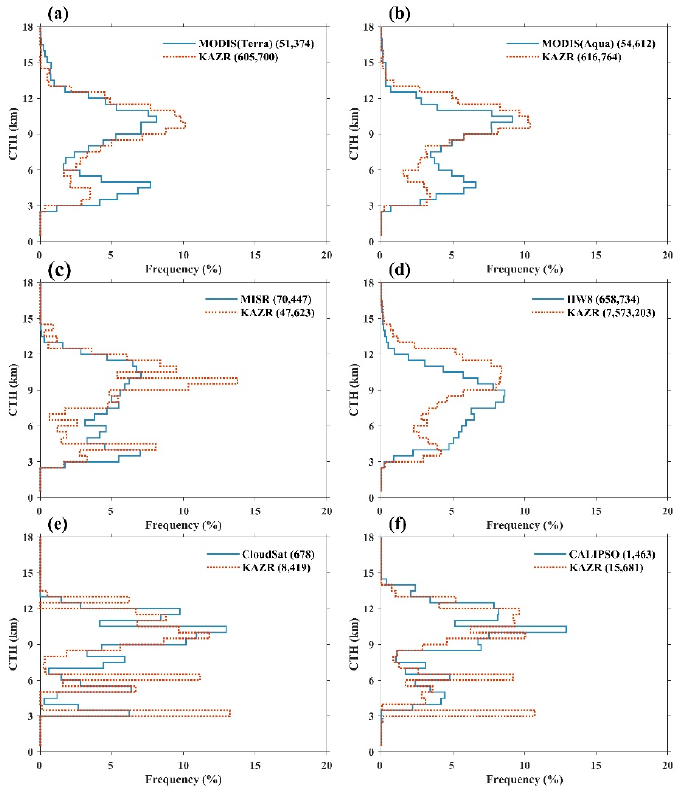
Figure 3. Frequency histogram of CTH (per 500 m interval) above the mean sea level for non- overlapping clouds. The number of cloudy samples from the satellite subpixels and associated KAZR profiles are also presented. These subplots are for different satellite-KAZR pairs, ( a ) MODIS(Terra), ( b ) MODIS(Aqua), ( c ) MISR, ( d ) HW8, ( e ) CloudSat, and ( f ) CALIPSO. The seasonal distributions of CTH in Figure 4 depict that the differences between passive satellite sensors and KAZR-derived CTH are comparatively larger than that of active satellite sensors. For example, in winter, a MODIS-derived CTH higher than 6 km accounts for 56% of the total cloud samples, while this proportion for KAZR is about 82%, suggesting that the distribution differences in Figure 3a,b are dominated by clouds in winter. The vertical CTH distribution of HW8 is also quite different from that of KAZR in winter (Figure 4(d4)). Previous studies have shown that high-latitude cirrus clouds occur more often during the cold season over the SACOL site [30,33]. These cirrus clouds may not be well identified by the CO 2 -slicing technology used by MODIS and HW8, which is susceptible to the albedo of snow and ice surface [22,46,64]. The CTH frequency distribution from MISR exhibits a good consistency with KAZR observation in winter and autumn, but significant differences appear in summer (in Figure 4(c2)) when MISR CTH distributes at a lower altitude than KAZR, primarily from the high and thin clouds caused by the high surface temperature [46,50,65]. Active satellite sensors show good agreement with KAZR especially for high clouds in all seasons. The underestimations of CTH